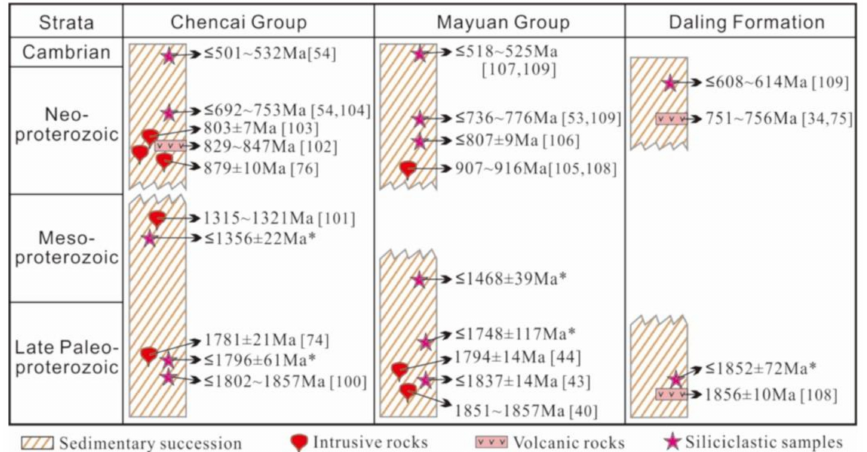
Figure 5. Summarized geochronological frameworks of the Chencai and Mayuan Groups and the Daling Formation in the northeastern Cathaysia block. Ages shown in the figure are crystalliza- tion ages for the magmatic rocks and maximum depositional ages for the siliciclastic sediment samples [34,40,43,44,53,54,74–76,100–109]. * Data are from this